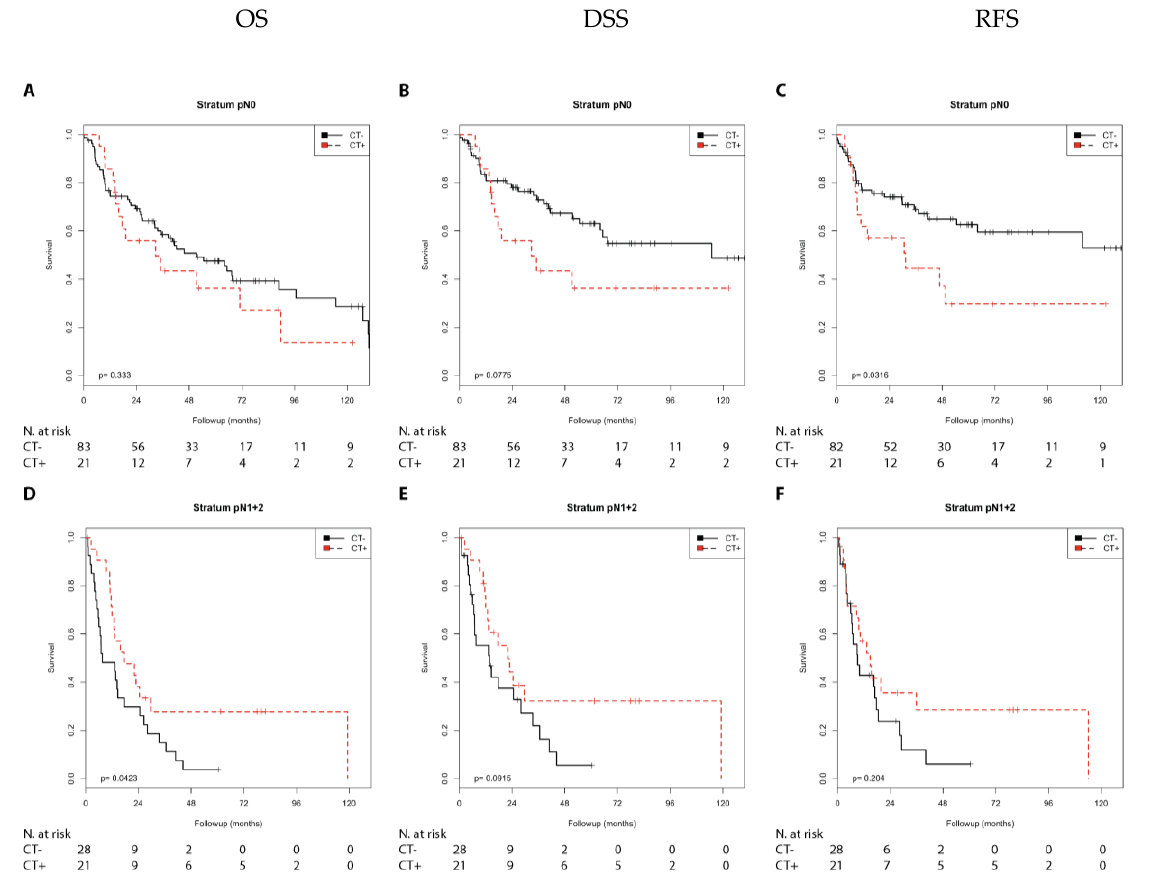
Figure 1. Kaplan–Meier analysis: Association of chemotherapy with prognosis (overall survival (OS), disease-specific survival (DSS), and recurrence-free-survival (RFS)) stratified by lymph node stage (N0 or N1 + 2). In the N0 group ( A – C ), chemotherapy was not associated with OS ( A ) but showed a trend of association with DSS ( B ; p = 0.078) and was associated with RFS ( C ; p = 0.032). In the N1 + 2 group ( D – F ), chemotherapy was associated with OS ( D ; p = 0.042), showed a trend of association with DSS ( E ; p = 0.091) and was not associated with RFS ( F ).